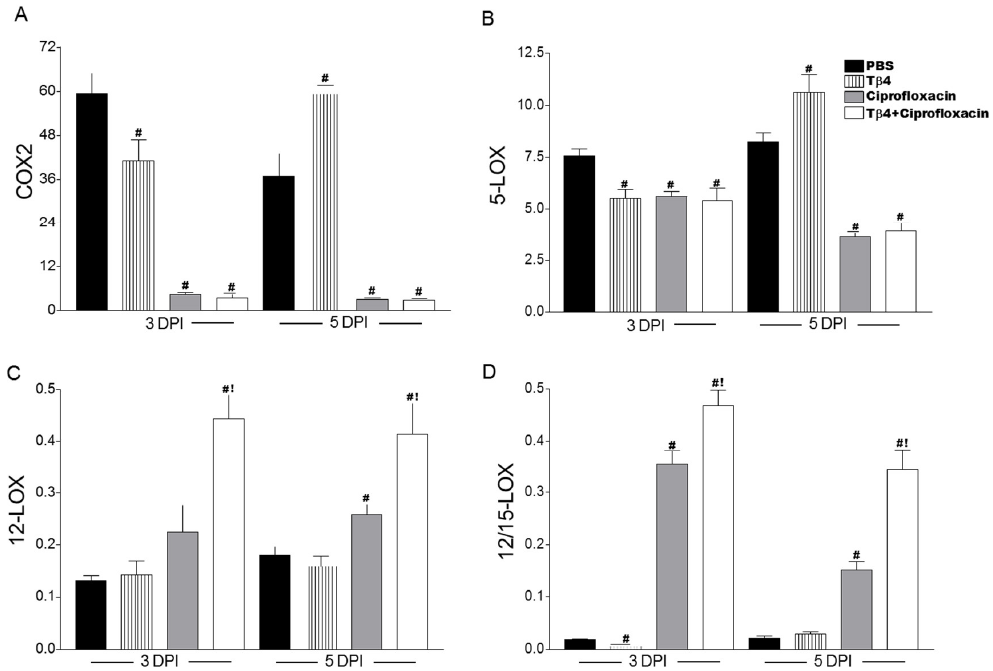
Figure 8. Real-time RT-PCR of lipid mediator biosynthetic enzymes, COX-2 ( A ), 5-LOX ( B ), 12-LOX ( C ), and 12/15-LOX ( D ) in corneas of PBS-, T β 4-, ciprofloxacin-, and T β 4 + ciprofloxacin-treated B6 mice at 3 and 5 days p.i. mRNA expression levels are normalized to β -actin and represented as relative fold change for the gene of interest compared to normal (uninfected) controls ± SEM. N = 8 corneas/group/time point. # P < 0.05 versus PBS; ! P < 0.05 versus ciprofloxacin.